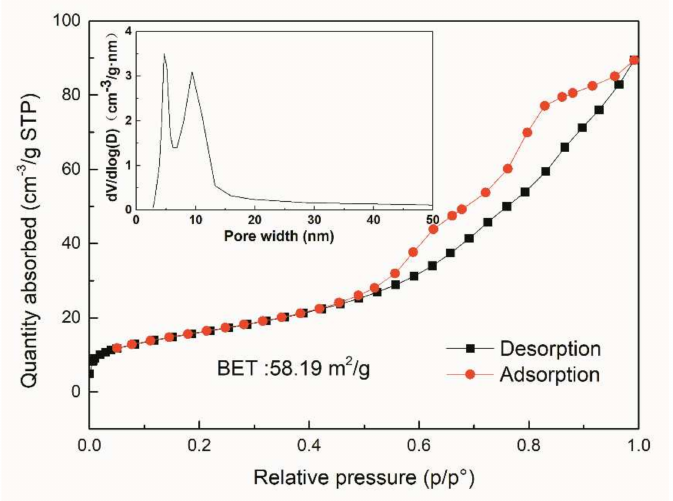
Figure 5. N 2 adsorption–desorption isotherms and pore size distribution of h-Al 2 O 3